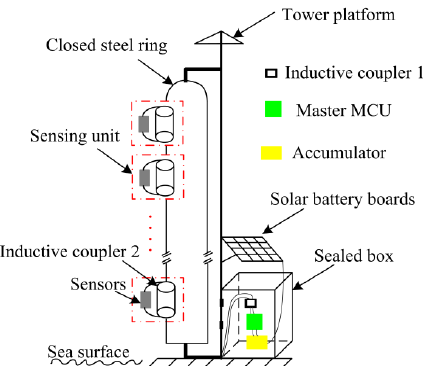
Figure 1. General overview of the proposed system for measuring the evaporation duct.